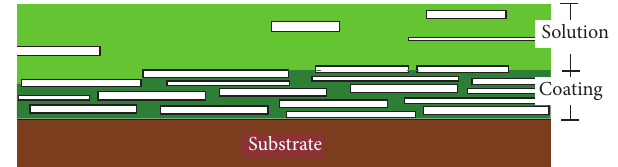
Figure 9: Representation of depositing exfoliated layered silicate (white) with cerium ions in solution (light green) and cerium oxide (reduced form in coating is dark green) on a substrate